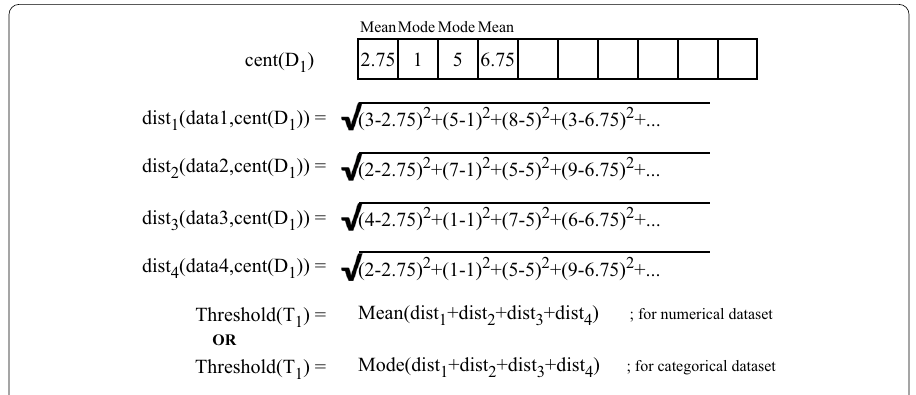
Fig. 5 An example of the class center and distance calculations for Class 1 for the mixed